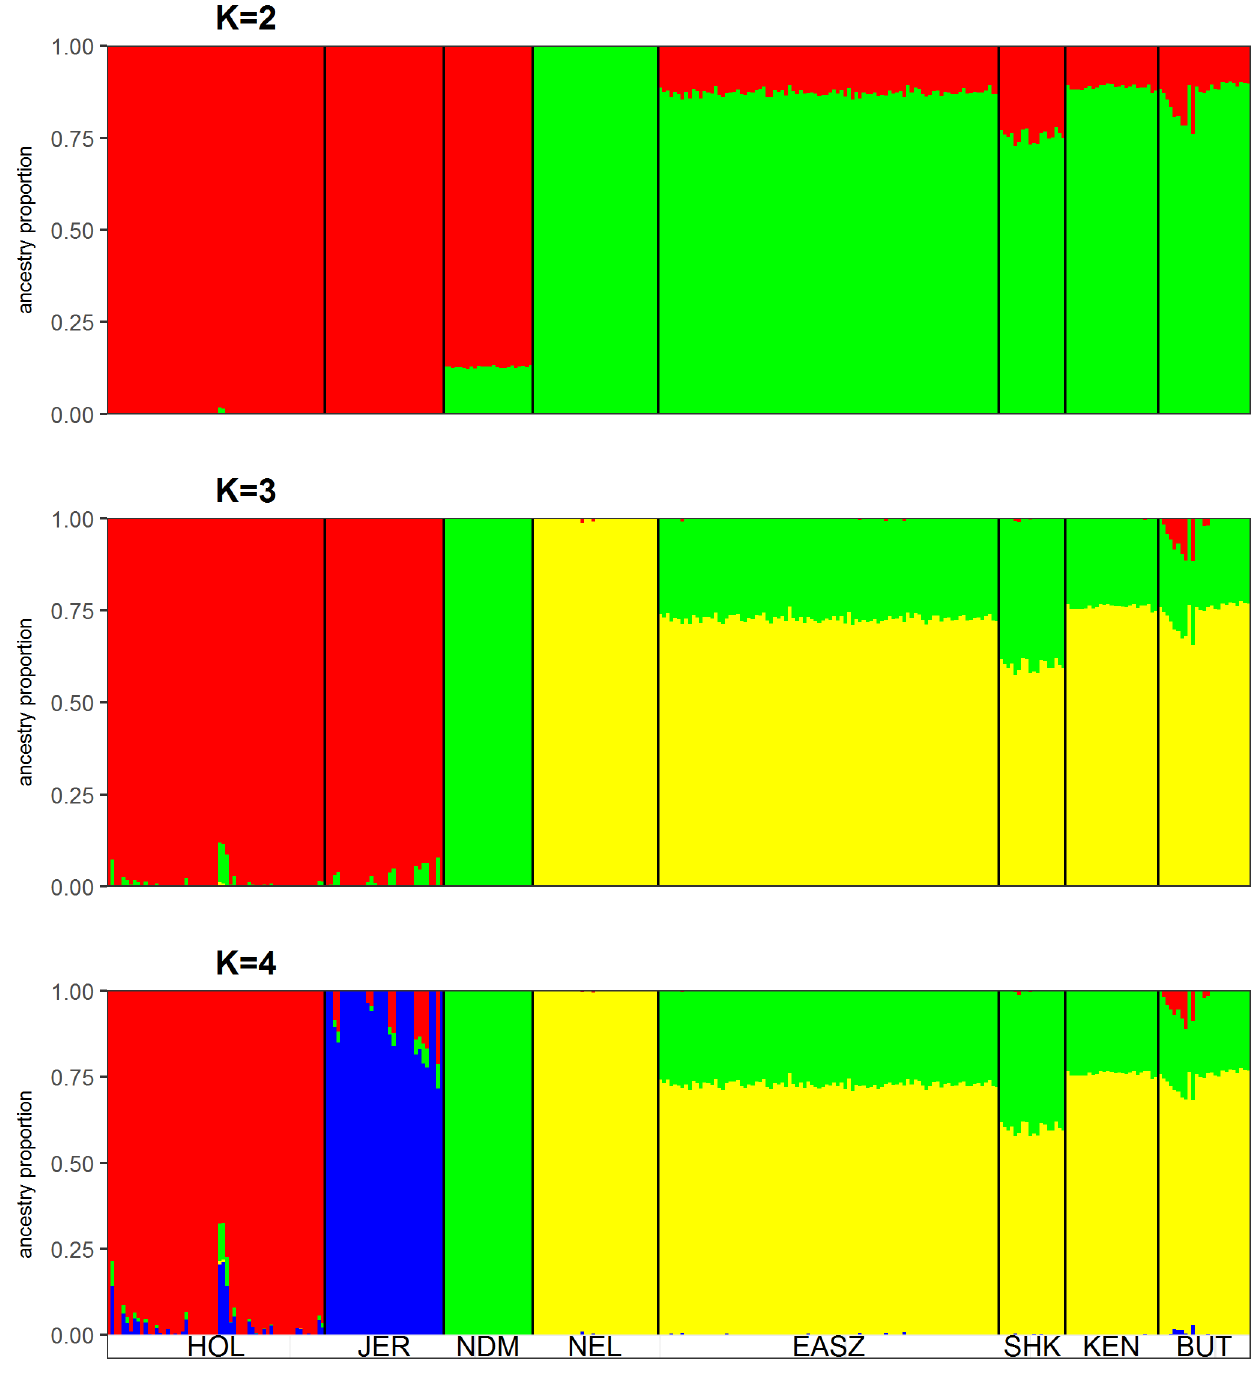
Fig 2. ADMIXTURE bar plots of genomic membership proportions from K = 2 to K = 4. Each sample is represented by a vertical line dividedinto K colours. HOL: Holstein, JER: Jersey, NDM: N’Dama,NEL: Nelore,SHK: Sheko, KEN: Kenana, BUT: